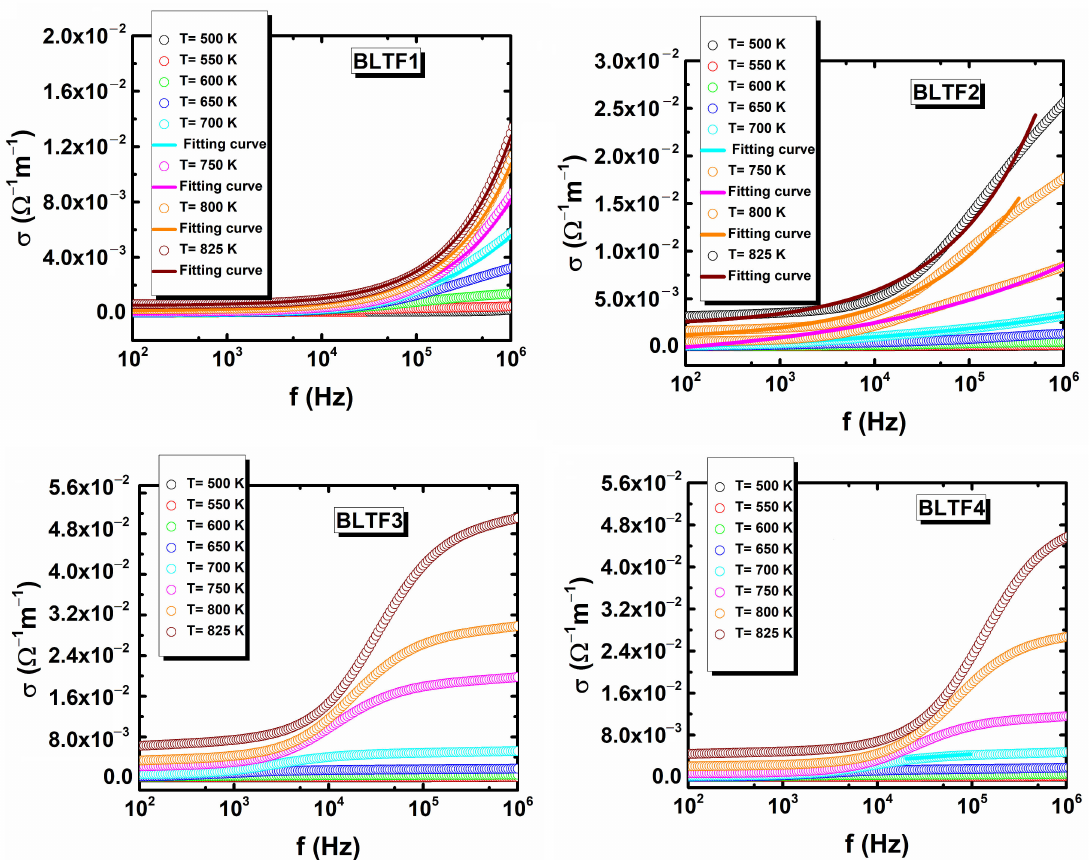
Figure 8. Frequency dependence of AC conductivity of BLTF ceramic at di ff erent